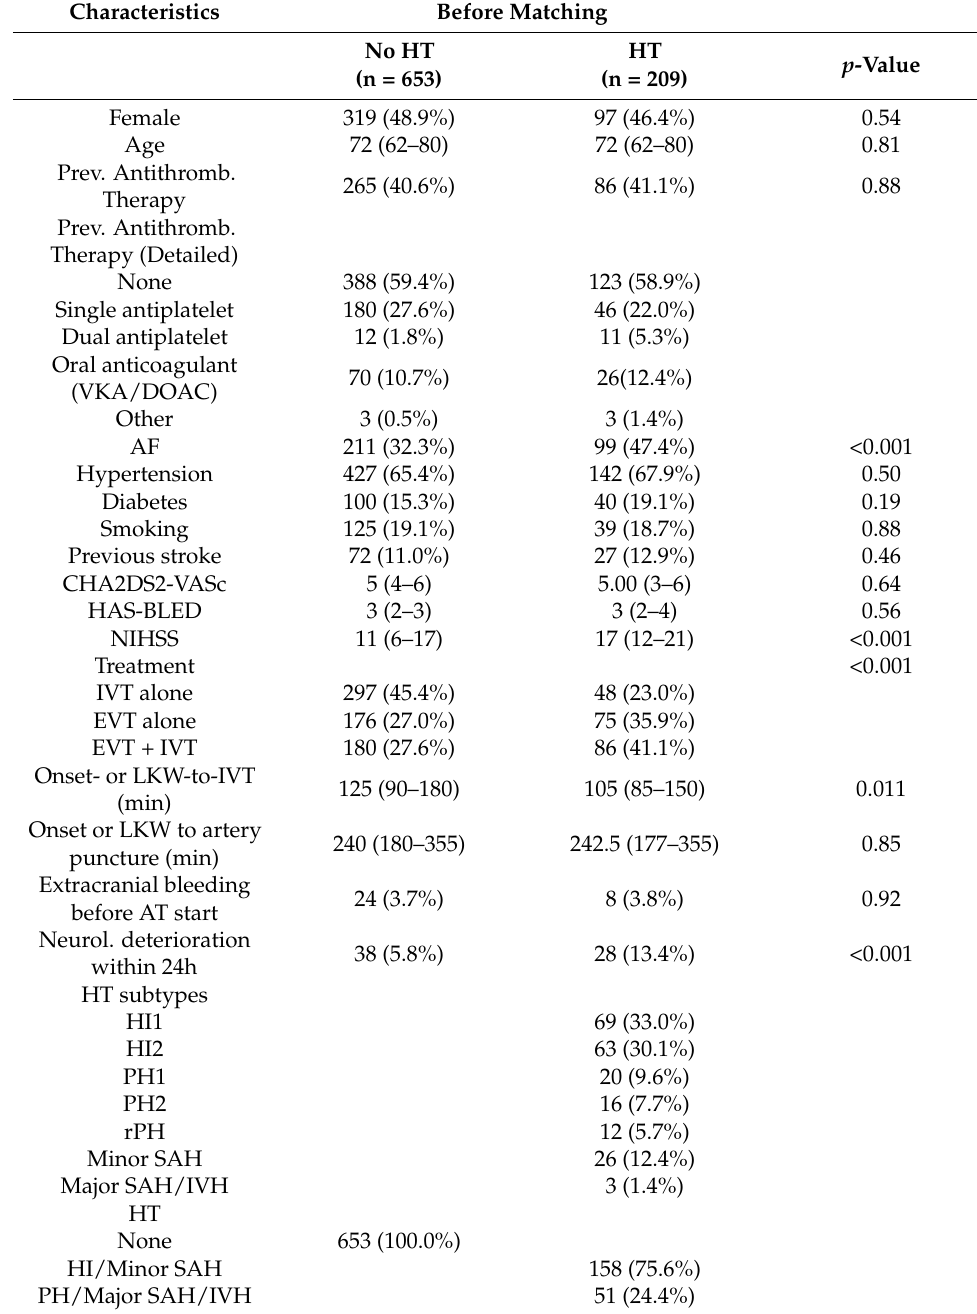
Table 1. Comparison of baseline characteristics between no HT and HT groups before